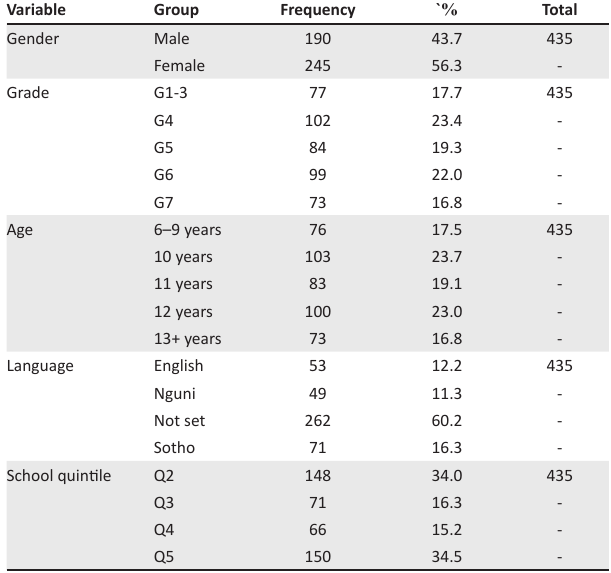
TABLE 1: Frequencies of data across gender, grade, age, language, and school quintile. Variable